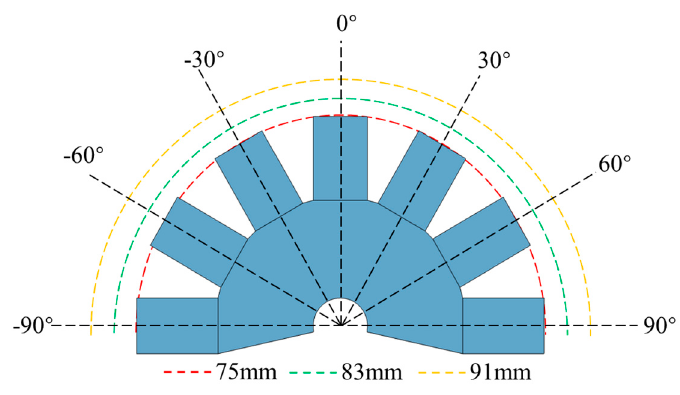
Figure 4. Measurement position of magnetic induction intensity.